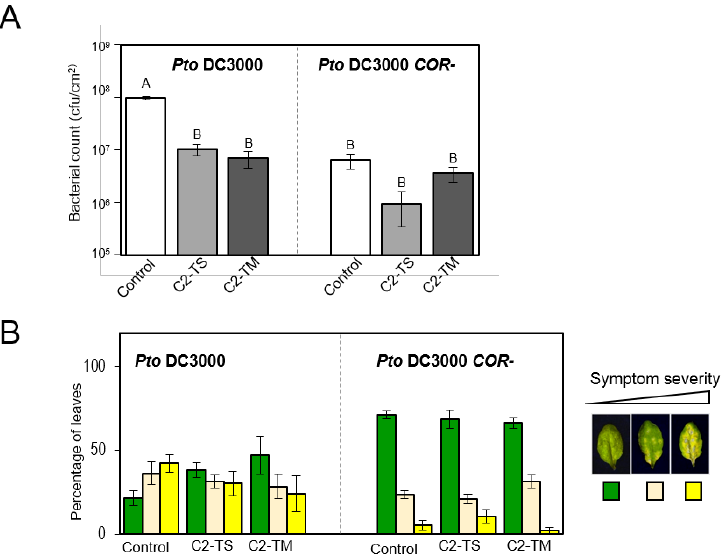
Figure 1. Infection of C2-expressing plants with Pseudomonas syringae pv. tomato DC3000. ( A ) Bacterial growth of wild-type ( Pto DC3000) or a deficient strain unable to synthesize coronatine (COR-) in wild-type Col-0 (control) or transgenic C2-expressing plants in dip-inoculation experiments. Samples were taken at 4 dpi. Values are the mean of five plants. Bars represent standard error. One-way ANOVA Tukey’s Multiple comparison tests were used to distinguish differences among samples at p -value <0.05. Different letters indicate statistically significant difference. Results are the mean of three independent biological replicates; ( B ) Symptoms displayed by dip-inoculated plants. Three different categories are considered: no symptoms, few symptoms or full symptoms, as indicated in the legend. The percentage of leaves in each category is represented. Bars represent standard error. In both ( A ) and ( B ), experiments were repeated three times with similar results; results from one representative experiment are shown.